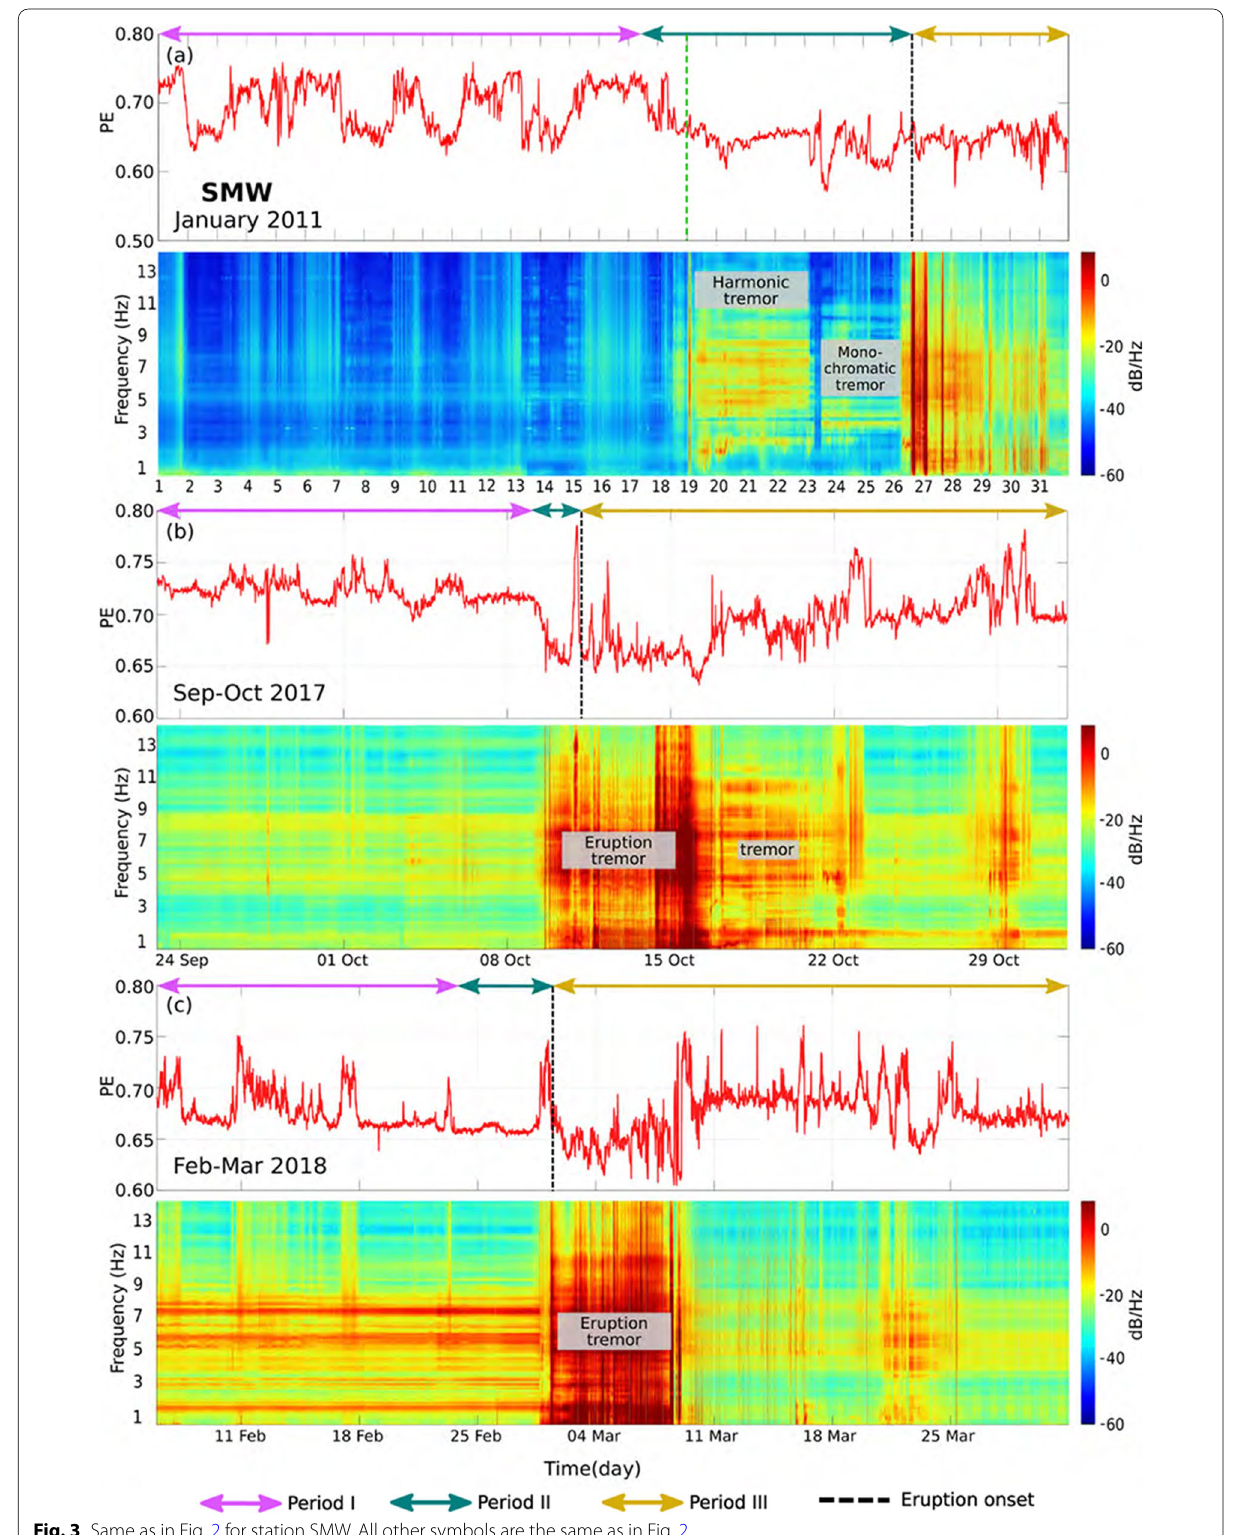
Fig. 3 Same as in Fig. 2 for station SMW. All other symbols are the same as in Fig.